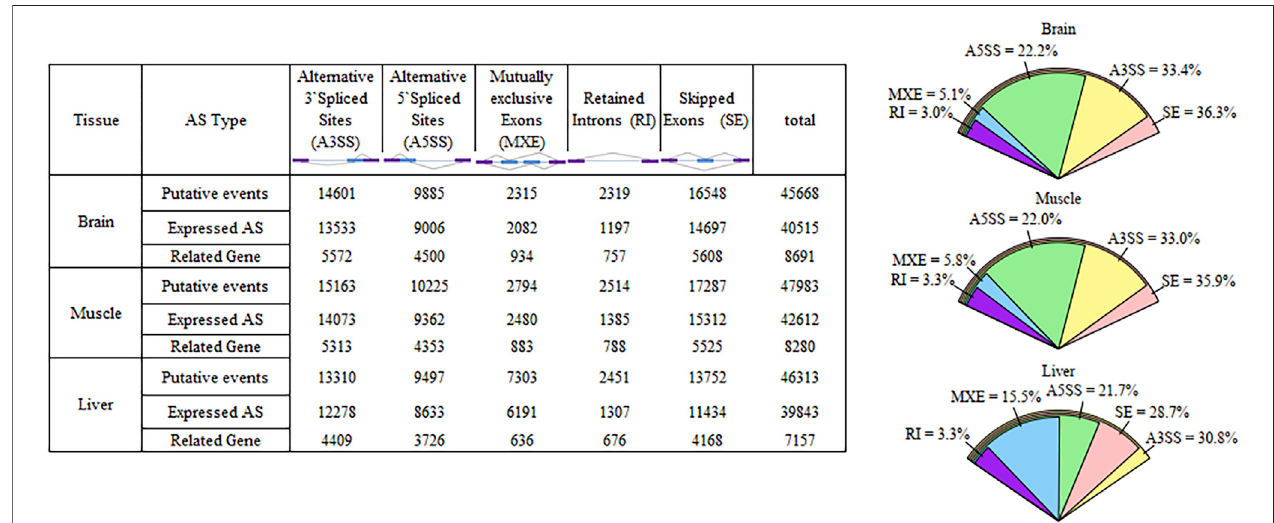
FIGURE 1 | Overview of alternative splicing in Cornish and White Leghorn.